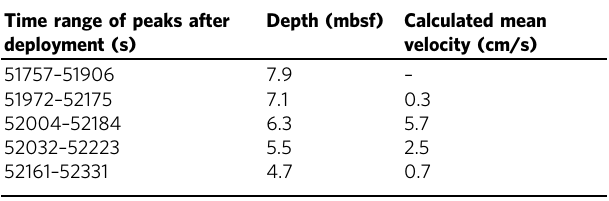
Calculated mean velocities at site PZM1 from the pore pressure recorded between 19:12:00 and